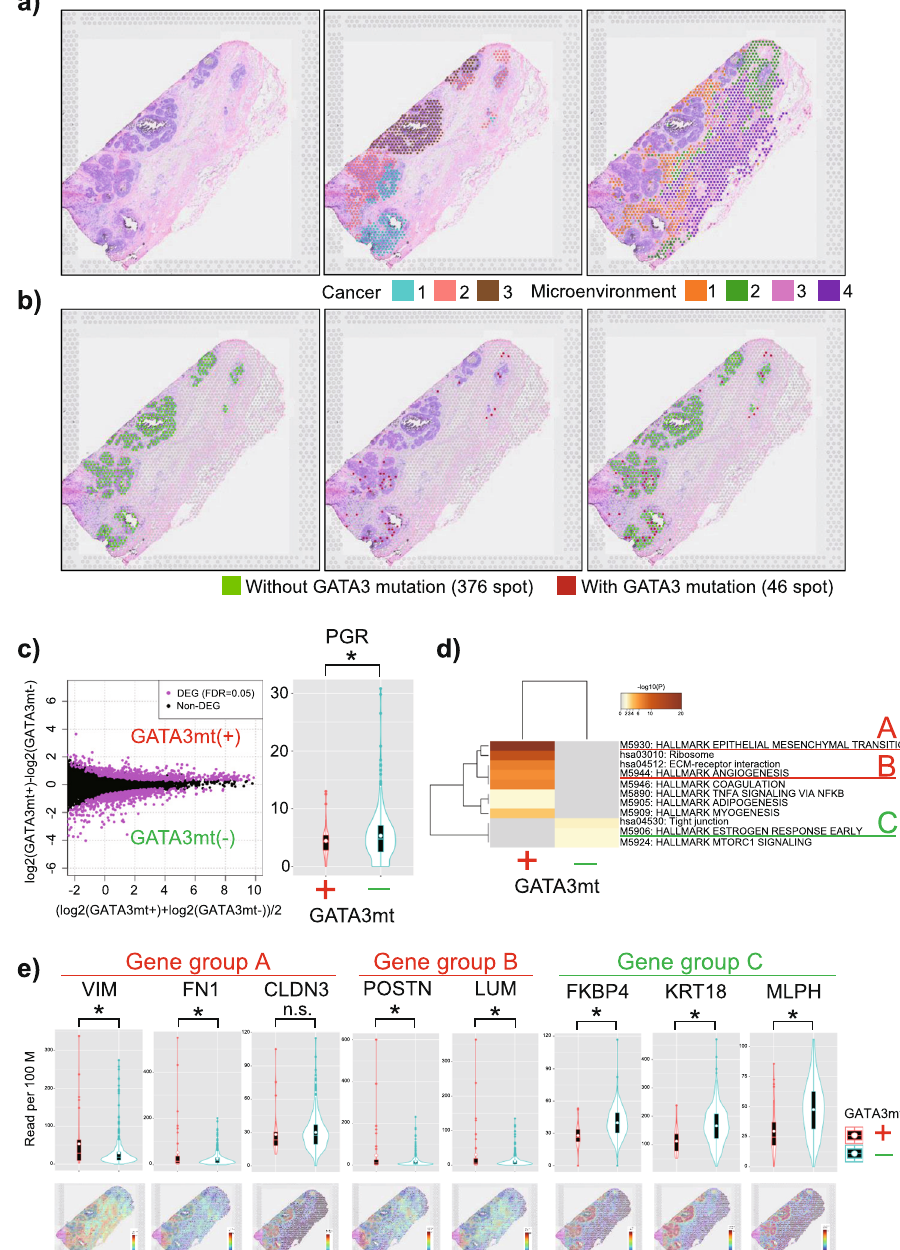
Fig. 3 Spatial transcriptome analysis of a patient with GATA3 mutation-positive ductal carcinoma in situ (DCIS) (Patient A). a Visualization of the Visium results for Patient A. Hematoxylin and eosin staining (left). In total, 2043 spots in the tissue are represented. Morphologically, those cells were classi fi ed as cancer cells in situ (405 spots) and noncancer cells (1638 spots). Three cancer cell populations classi fi ed via nonhierarchical k-means clustering (k = 9) are shown with different colors (middle panel). Four noncancer spots are similarly shown to represent the gene expression re fl ecting the microenvironments at the corresponding positions (right panel). b The spots in which GATA3 mutations were detected as transcriptomic tags are colored red. Of the 422 spots morphologically located with cancer cells, a GATA3 mutation read was found for 46 spots. c MA plot presenting differentially expressed genes (DEGs) between spots with and without GATA3 mutations. In total, 1468 DEGs were detected at a false discovery rate of <0.05 (left). The right panel shows a comparison of progesterone receptor ( PgR ) expression at each spot. Decreased PgR expression was more frequently observed in the spots with GATA3 mutations ( P = 0.02901, one-sided t -test). d Results of the enrichment test for the MSigDB v5.1 Hallmark gene set collection (HALLMARK) and Kyoto Encyclopedia of Genes and Genomes (KEGG) pathways are presented. Each band represents one enriched term or pathway. The level of enrichment is color-coded as the − log 10 p value. As indicated, in the spots with GATA3 mutations, the DEGs were mainly enriched in epithelial- mesenchymal transition ( “ Gene group A ” ) and angiogenesis ( “ Gene group B ” ). Conversely, in the spots without GATA3 mutations, the DEGs were mainly enriched in tight junctions, estrogen response ( “ Gene group C ” ), and MTORC1 signaling. e Violin plots showing the expression of representative genes corresponding to the gene groups of A – C. The expression of the indicated gene was compared between the spots with and without GATA3 mutations in the upper panel. * P < 0.05 (one-sided), n.s.: not signi fi cant. The gene expression levels in the tissue are shown in the bottom